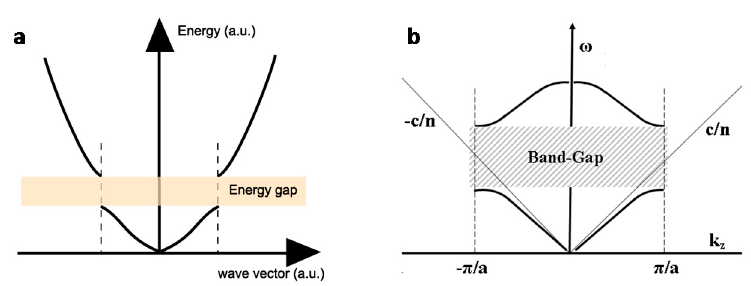
Figure 2. Analogy between the ( a ) energy gap in semiconductors and the ( b ) band-gap in photonic crystals.